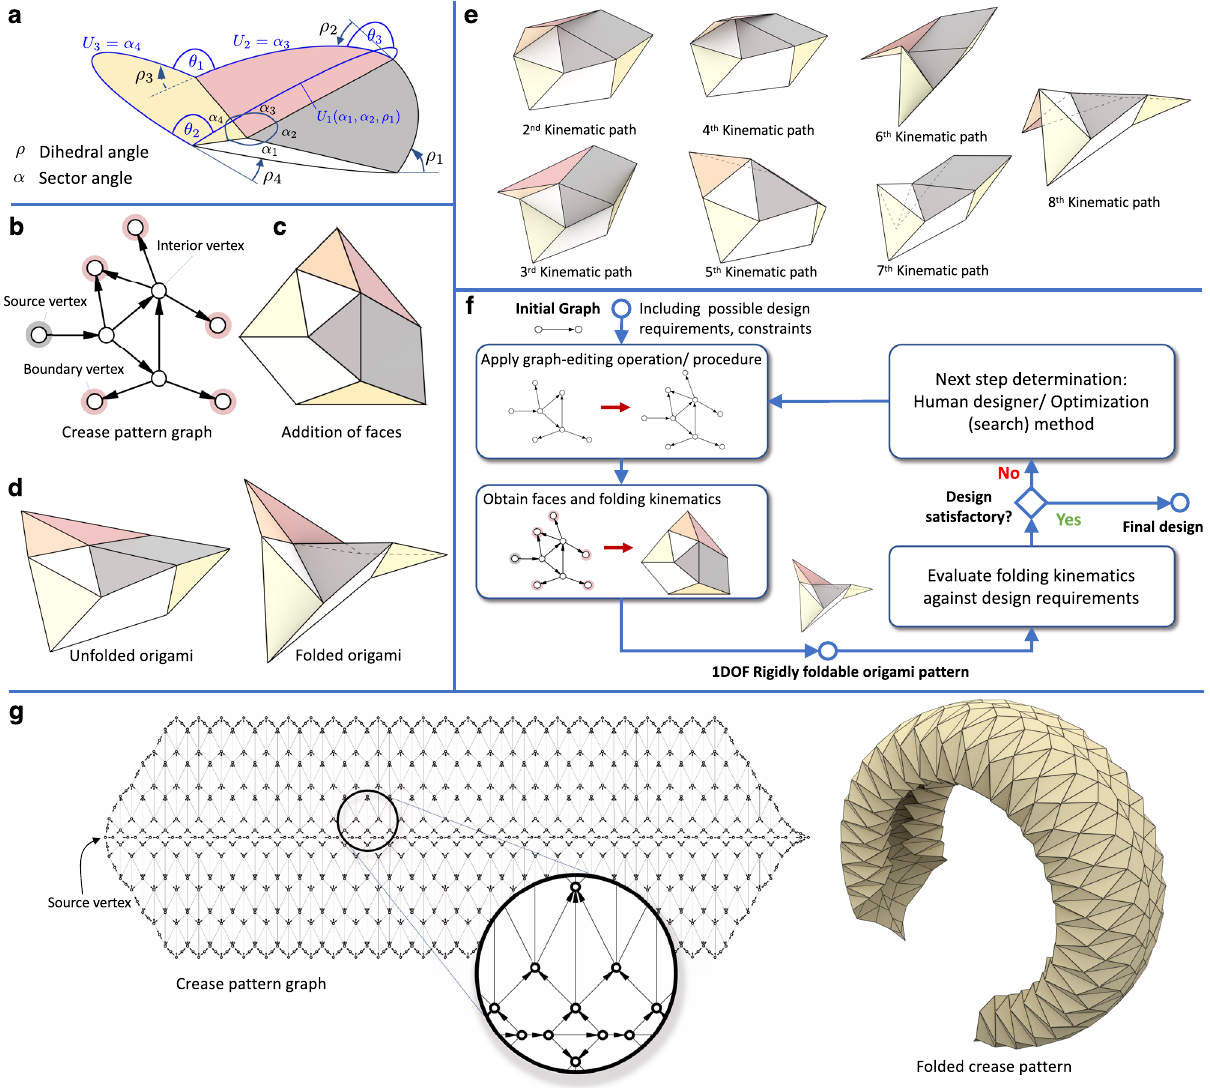
Fig. 1 Using the Principle of Three Units (PTU) for analyzing and creating origami crease patterns. a Notational convention for angles. Dihedral angles ρ are positive for valley folds and negative for mountain folds. b Sample crease pattern graph with three interior vertices, c Corresponding crease pattern, d Unfolded and folded con fi guration of the crease pattern. e Folded con fi gurations of the same crease pattern as in Fig. 1b – d folded along different kinematic paths. f Generic design procedure based on the proposed algorithmic approach. g Sample crease pattern graph with 392 interior vertices and folded con fi guration of the corresponding crease pattern. The graph also contains auxiliary vertices which connect boundary vertices to form boundary faces (leading to boundary vertices having two outputs). Auxiliary vertices only control the shape of the boundary faces and have no impact on the folding kinematics (for further details see Supplementary Note